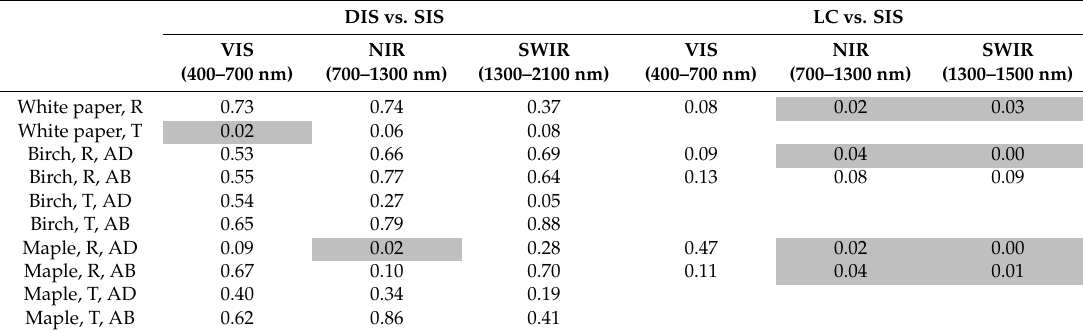
equality of variances. Table A2: Welch’s t -test for equality of mean spectra. Table A3: Welch’s t -test for equality of mean spectral indices. Table B3. Statistical differences in spectral indices calculated with different methods. The values Table A1. Mean p -values in Levene’s test comparing homogeneity of variances between measurement shown are p -values in a t -test comparing double integrating sphere (DIS) or leaf clip (LC) to single methods. The value for each wavelength region (VIS, NIR, SWIR) is the mean of individual p -values integrating sphere. Statistically significant values ( p < 0.05) are highlighted. R = reflectance, T = of all 1 nm bands belonging to the region. Statistically significant regions ( p < 0.05) are transmittance, AD = adaxial side, AB = abaxial